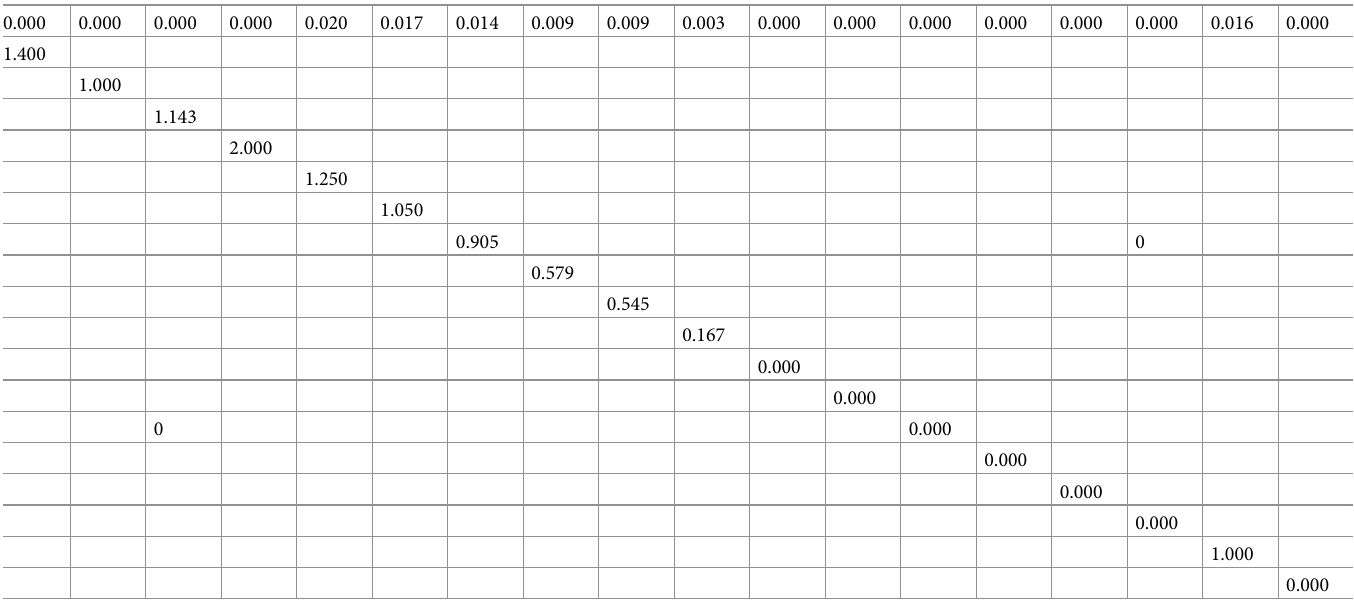
Table 8. Leslie matrix model of P . flavus WM